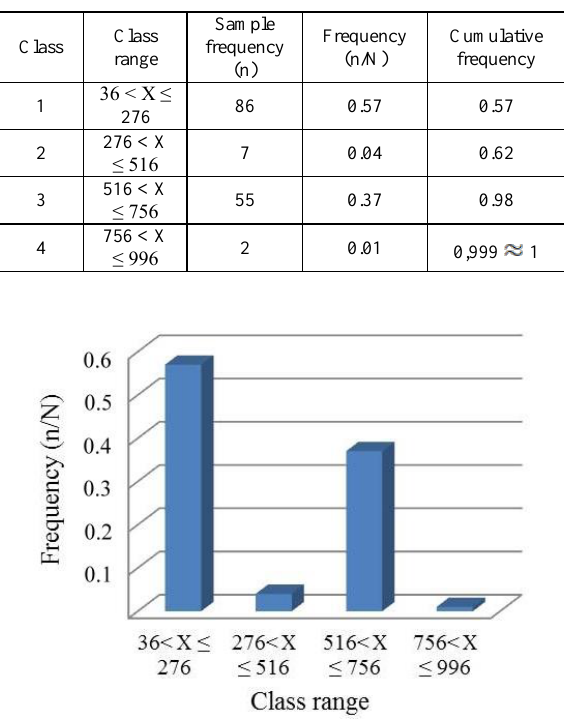
Table 2. Frequency analysis of influent TSS